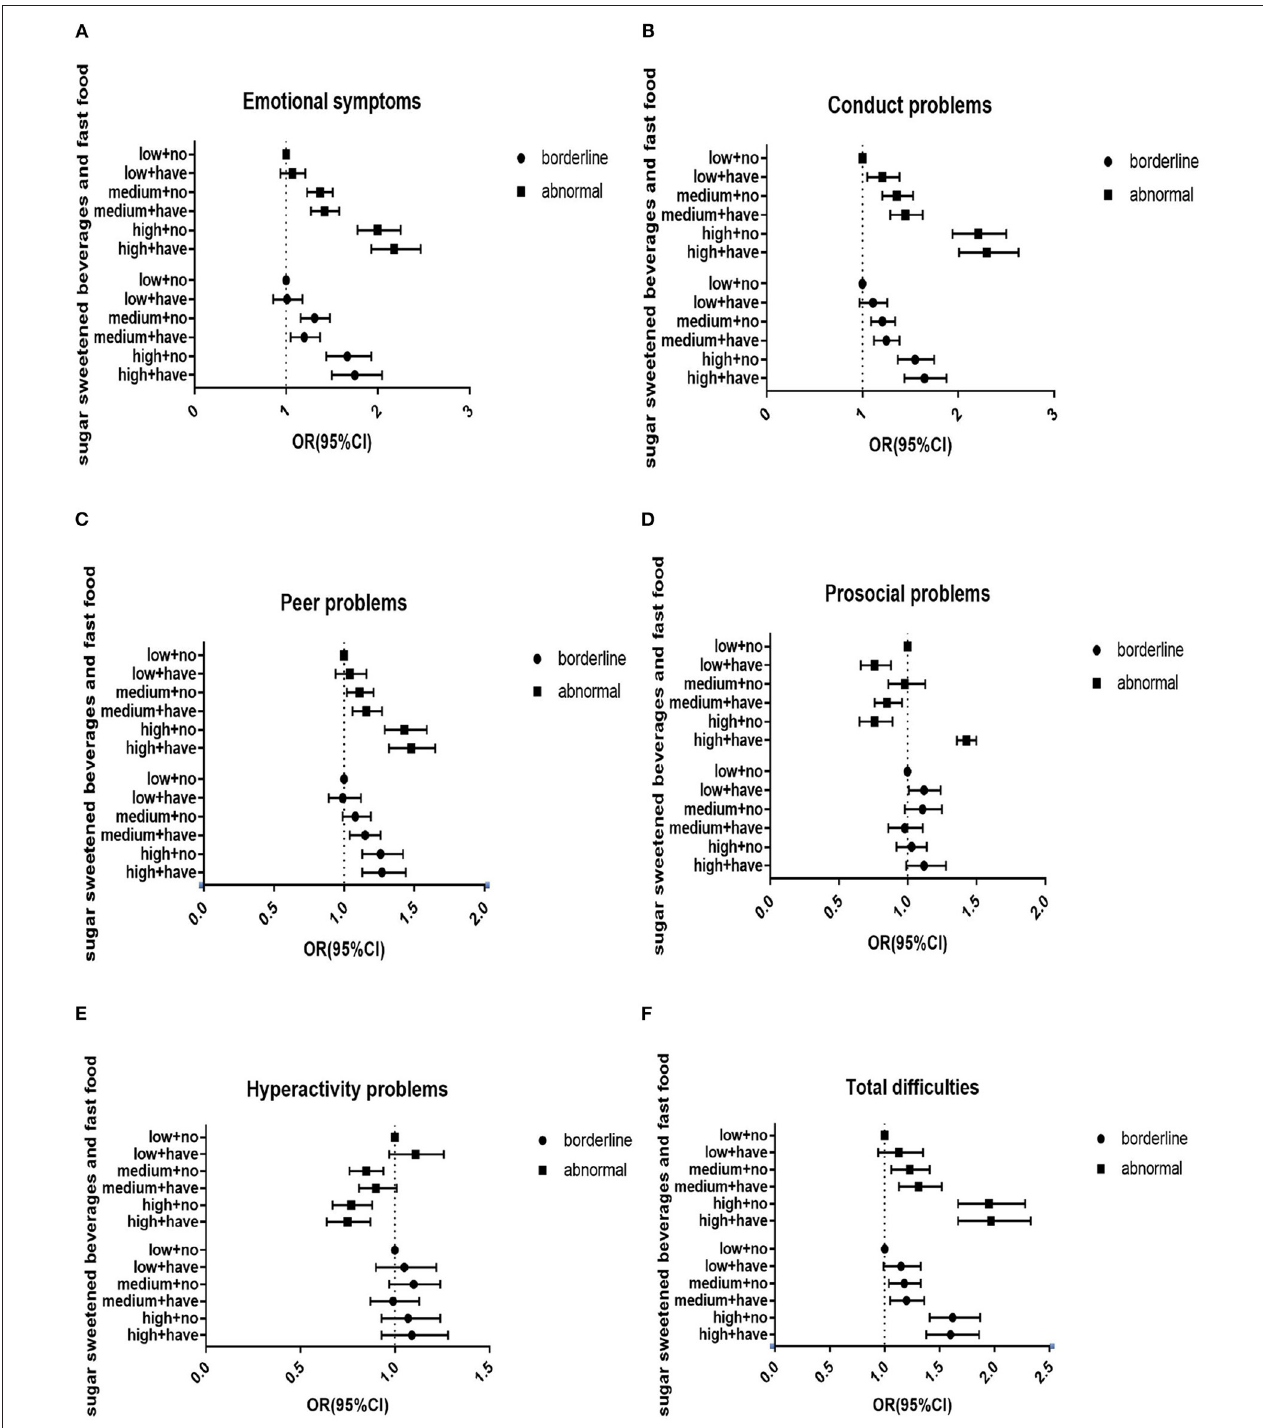
FIGURE 1 | Interactive effects of sugar-sweetened beverages and takeaway pattern on psychological and behavioral problems among Chinese children and adolescents. (A) Interactive effects of sugar-sweetened beverages and takeaway pattern on emotional symptoms. (B) Interactive effects of sugar-sweetened beverages and takeaway pattern on conduct problems. (C) Interactive effects of sugar-sweetened beverages and takeaway pattern on peer problems. (D) Interactive effects of sugar-sweetened beverages and takeaway pattern on prosocial problems. (E) Interactive effects of sugar-sweetened beverages and takeaway pattern on hyperactivity problems. (F) Interactive effects of sugar-sweetened beverages and takeaway pattern on total difficulties. Low, low SSB intake; Medium, medium SSB intake; High, high SSB intake; Have, have takeaway consumption; No, no takeaway consumption. The model was controlled for age, gender, grade, residential areas, academic record, family economic level, and parents’ education level. * p < 0.05; ** p < 0.01.